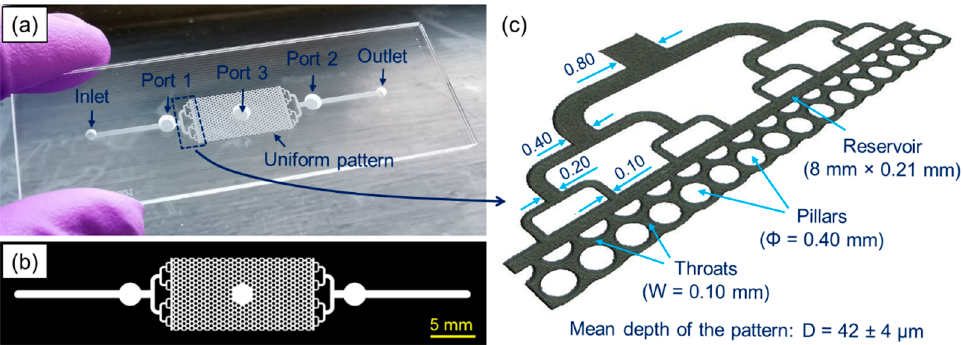
Figure 1. ( a ) Laser-manufactured, glass microfluidic device with three round ports (Ports 1–3) dedicated to attaching commercial fiber optic sensors, ( b ) schematic of the overall microfluidic pattern, and ( c ) dimensions of the key features (given in mm) measured at Full-Width-Half-Maximum using an Alicona G4 InfiniteFocus 3D surface profilometer.